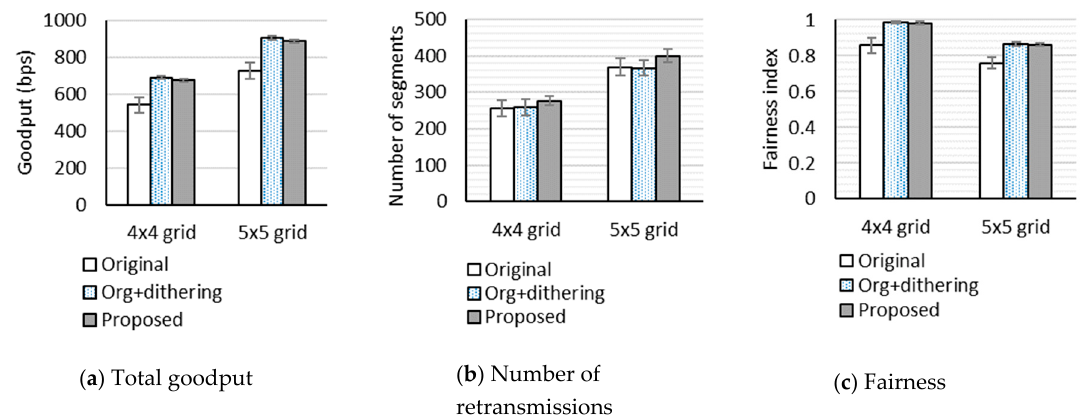
Figure 4. Performance in 4 × 4 grid and 5 × 5 grid topology networks when no RDC mechanism is used.